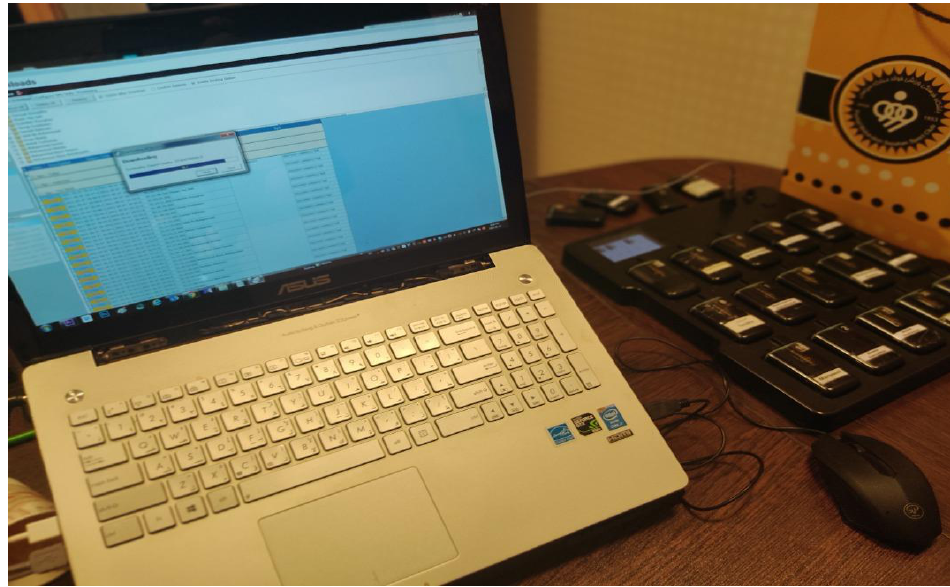
Figure 4. How to obtain the calculated information in each training session and matches.